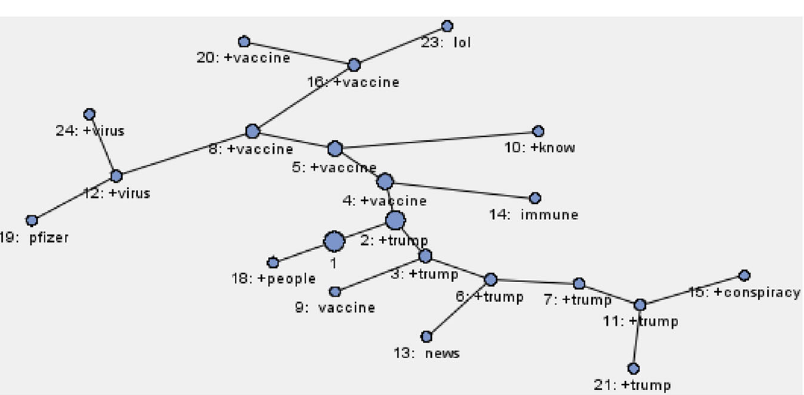
Fig. 2 Cluster hierarchy graph. It presents cluster hierarchy in the study. Clusters are represented as nodes. The distance of two clusters is modelled by a certain weight on the edge linking the